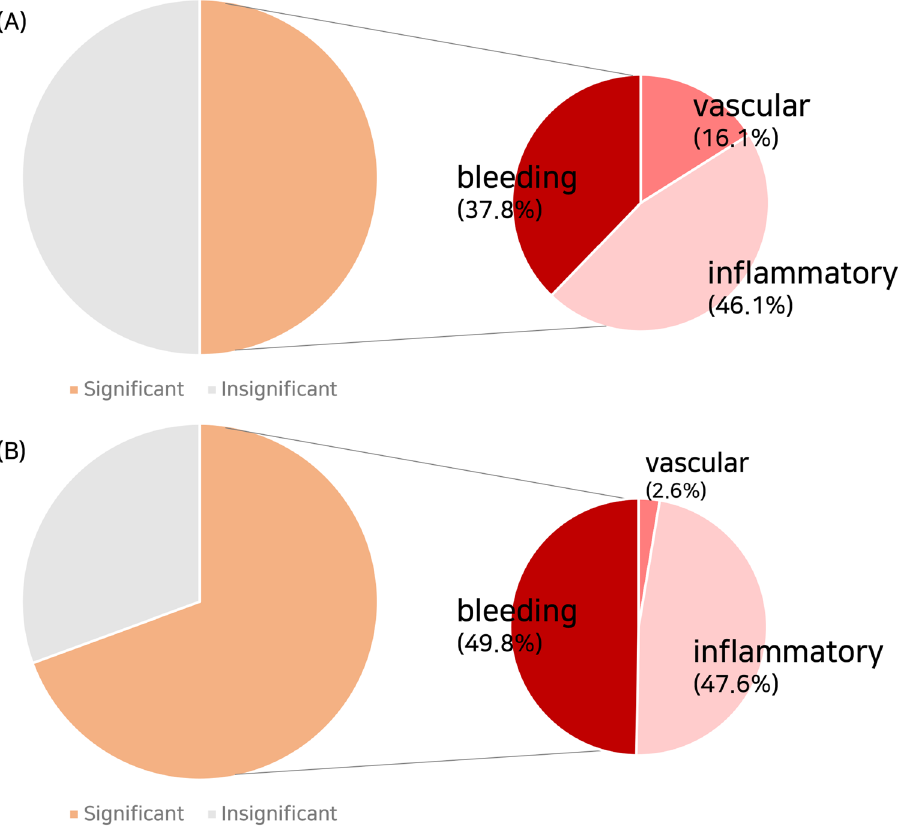
Figure 3. Composition of two datasets, such as the ( A ) learning and internal test and ( B ) external test.